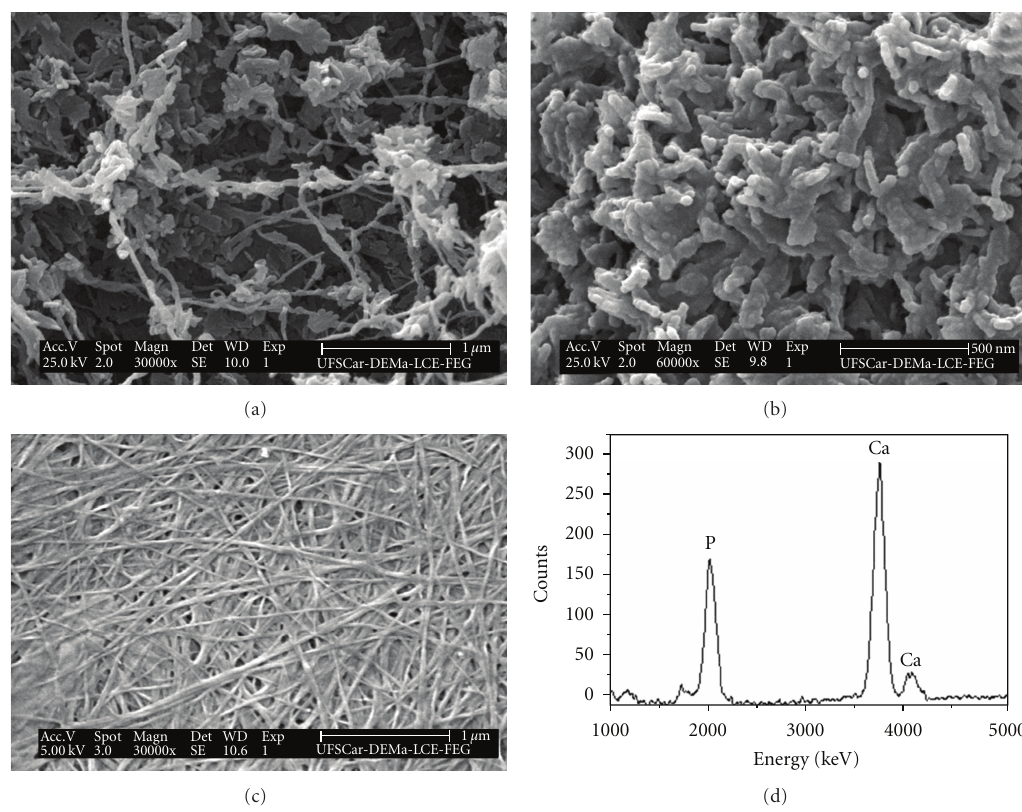
Figure 4: SEM images of the BC-HA nanocomposites (a) and (b) at 30.000 × and 60.000 × , respectively, and SEM images of the BC membrane (c) at 30.000 × . A 5kV accelerating voltage was used for the BC sample, and a 25 kV voltage was used to obtain the image of the BC-HA nanocomposites. EDS spectrum was taken from a typical nanofibril with surrounding HA crystals